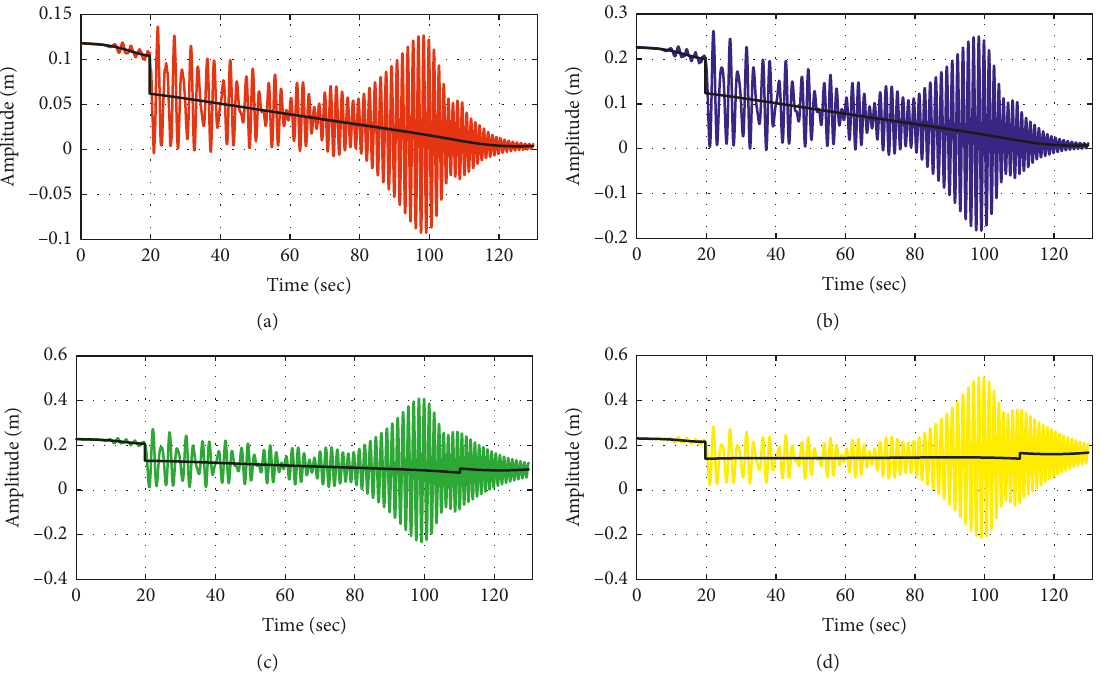
Figure 6: Longitudinal responses of the traction system at different positions. The (a) midpoint of the lifting rope, (b) conveyance, (c) midpoint of the compensating rope, and (d) end point of the compensating rope.